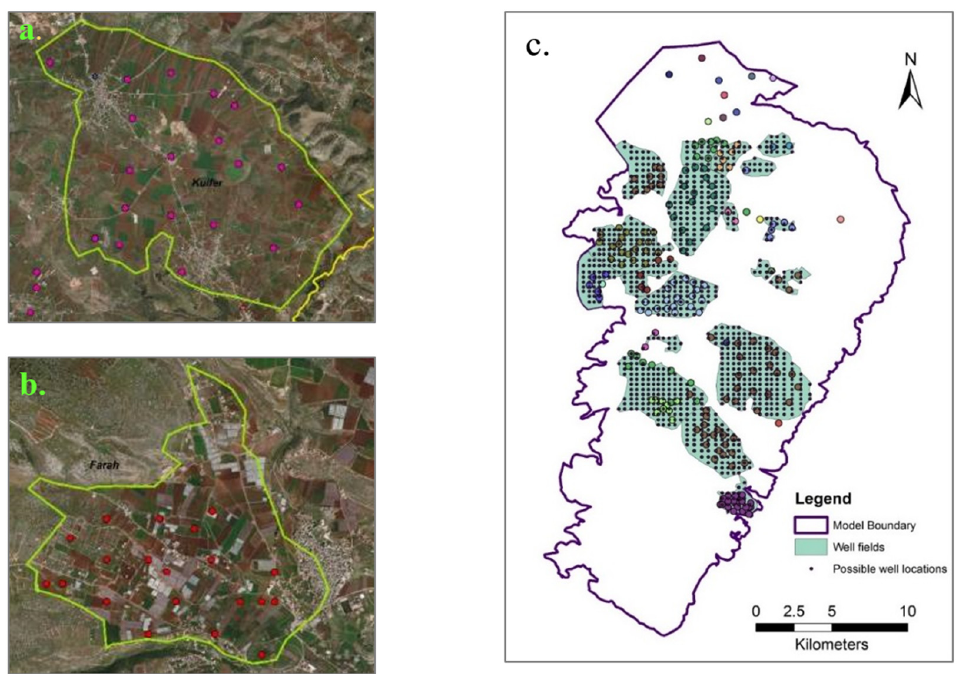
Figure 8. Delineation of the probable well field areas: ( a ) Kuifer well field; ( b ) Farah well field; ( c ) all well fields with possible well locations.